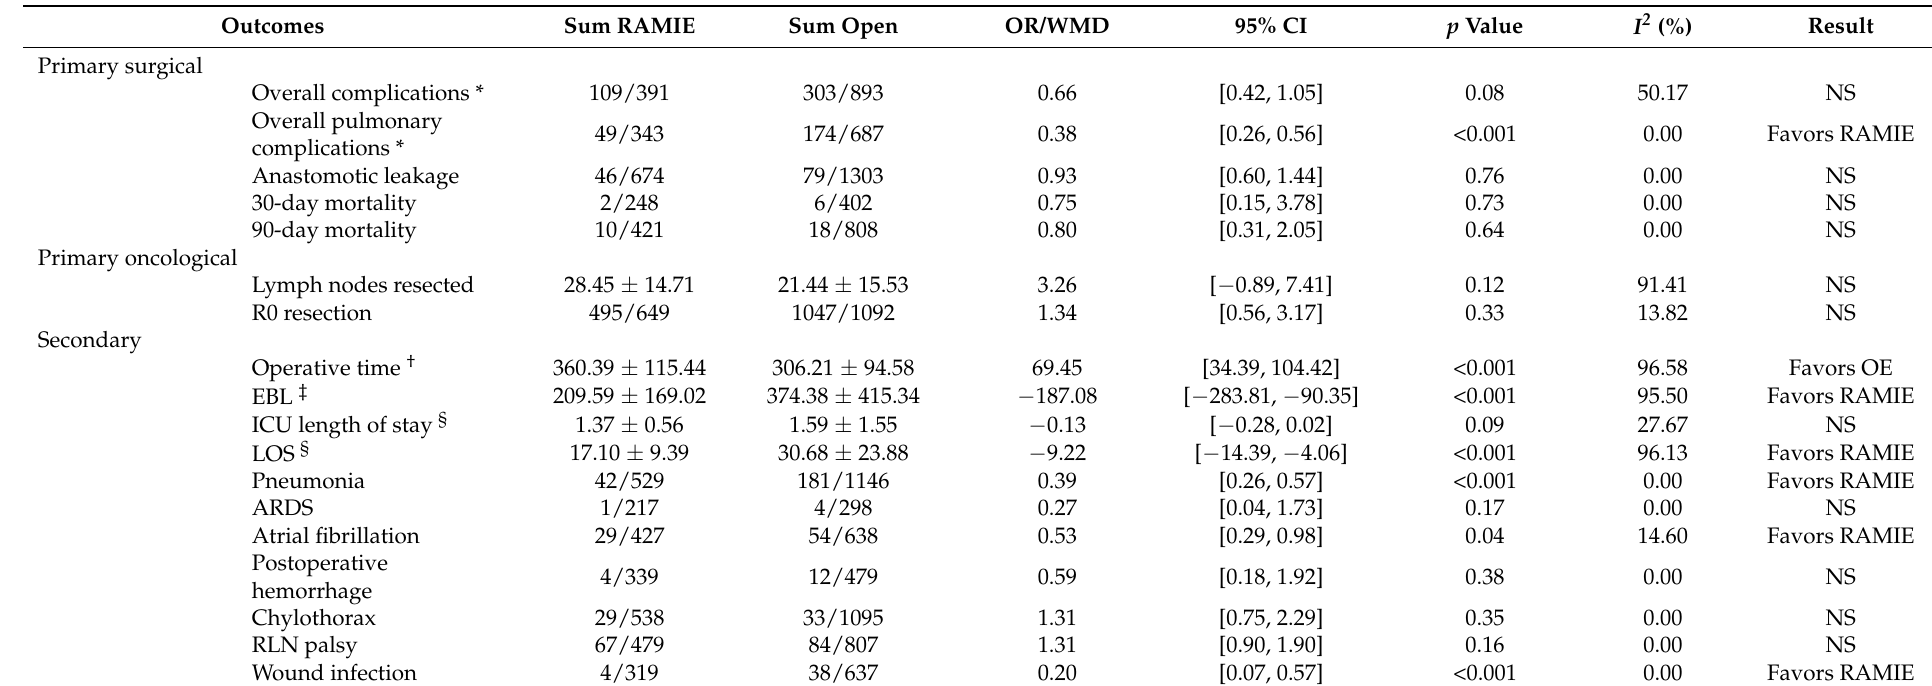
Table 3. Summary of meta-analyses for all